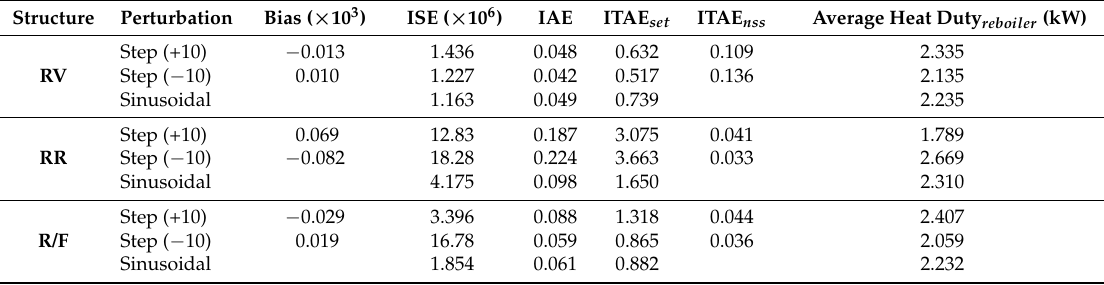
Table 9. Performance indicators of control structures—case of feed flux rate